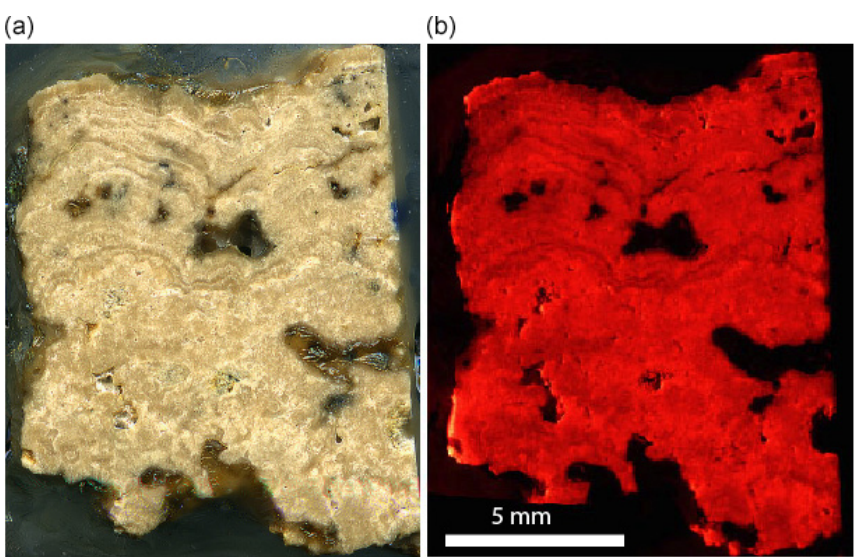
Figure 14. Slab from the Barstow Formation tufa sample that is being characterized for a possible secondary LAcarb standard. The fine laminae are like those described by Becker et al. (2001). The left image is a scan of the slab. The right image is a CL photomosaic from 360 images. Generally, the more micritic areas have a brighter luminescence, and the sparry layers have a duller luminescence.